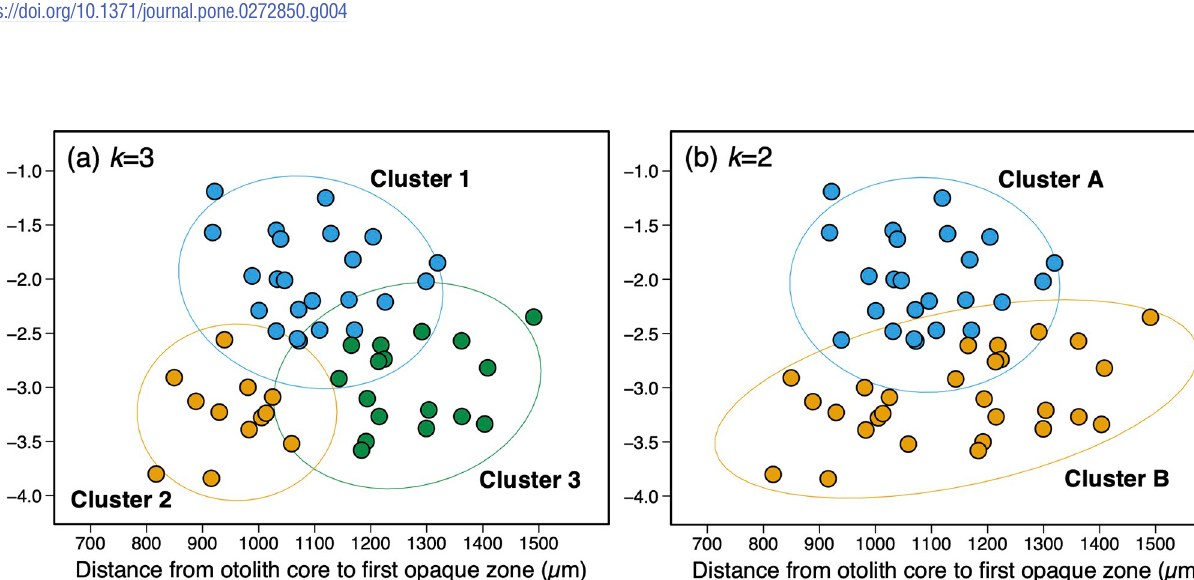
PLOS ONE | https://doi.org/10.1371/journal.pone.0272850 August 10,